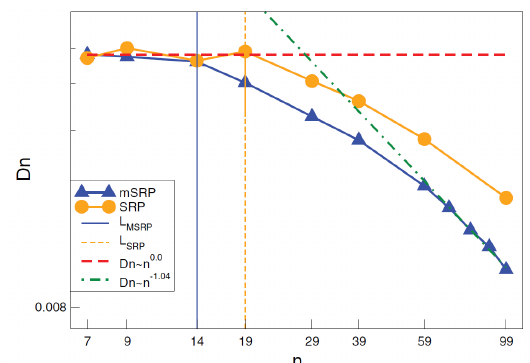
Figure 10. Diffusion as a function of chain length for mSRP and SRP. Rouse (dash) and reptation (dash-dot) scaling limits intersect at approximately N = 28 for mSRP. The initial deviation from Rouse diffusion scaling for mSRP and SRP occurs at N = 14 (solid) and N = 19 (small dash), respectively. Reprinted from [161] with permission from